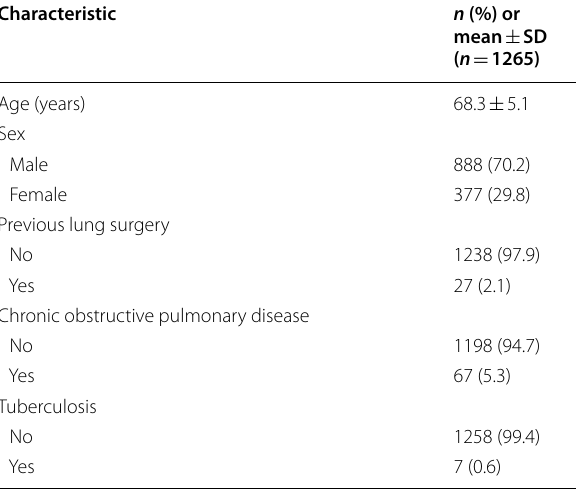
Table 2 Patients’ demographic and clinical characteristics